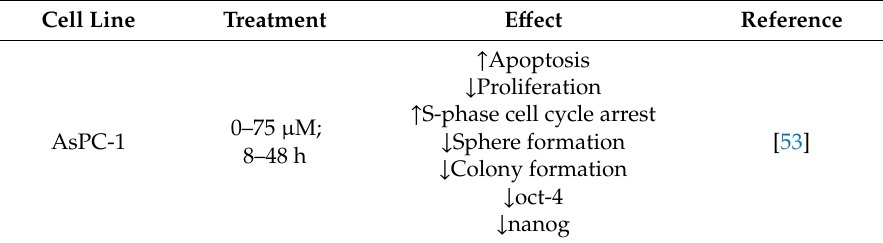
Table 5. E ff ects of carnosol on pancreatic cancer in